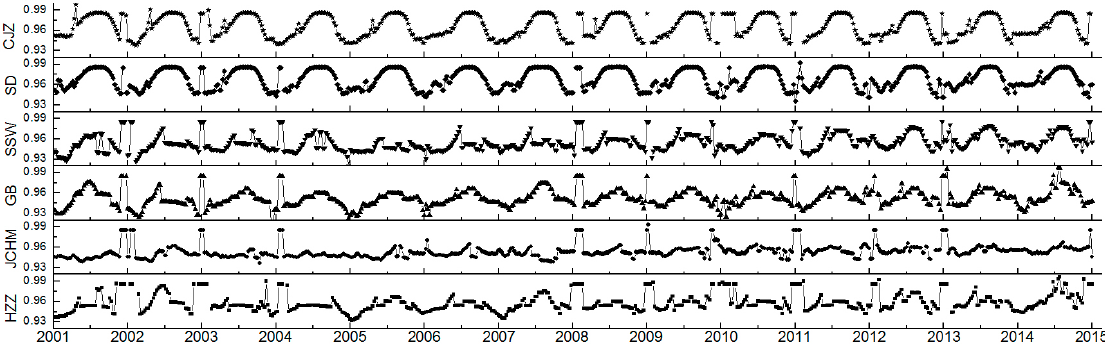
Figure 6. The BBE of each eight-day period from 2001 to 2014 for six stations.